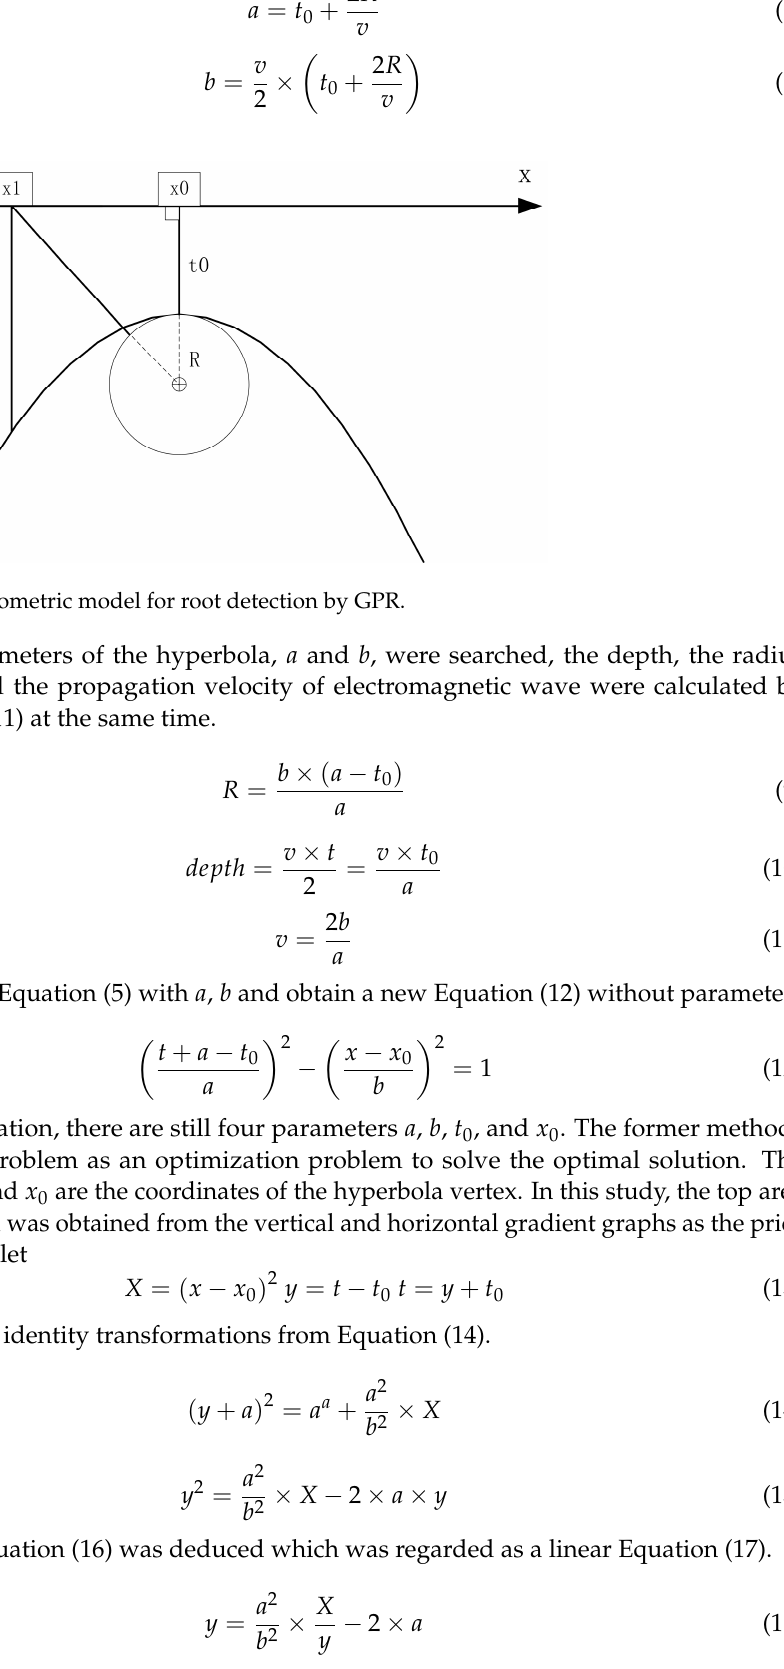
Figure 9. Parabola recognition with Hough transform after coordinating transformation. ( a ) Result for parabola recogni- tion when   = 0 . ( b ) Result for parabola recognition when   = 5 . ( c ) Result for parabola recognition when   = 10 .